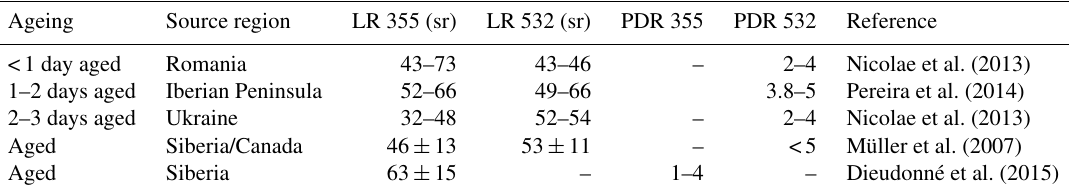
Table 3. Optical properties found in the literature about biomass burning events and used to compare with the obtained values of the warehouse fire SAL (smoke aerosol layer) in Table